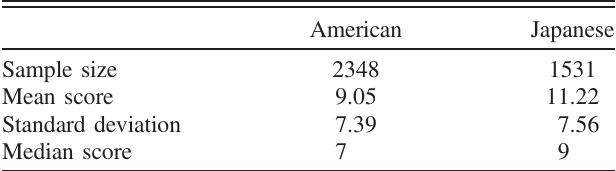
TABLE II. Statistics of the two samples.